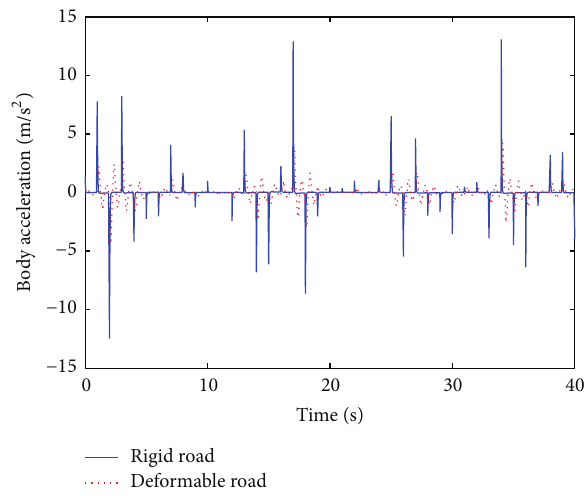
Figure 5: Comparison between the kinetic models of the rigid road and deformable terrain.